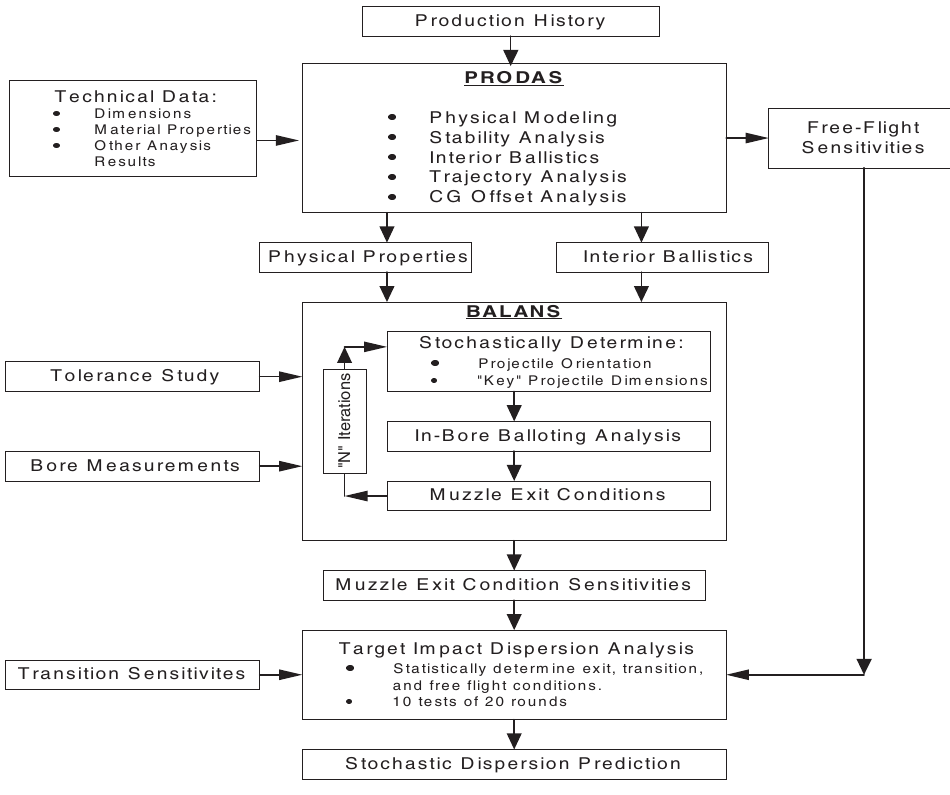
Fig. 6. Analytical approach to predicting